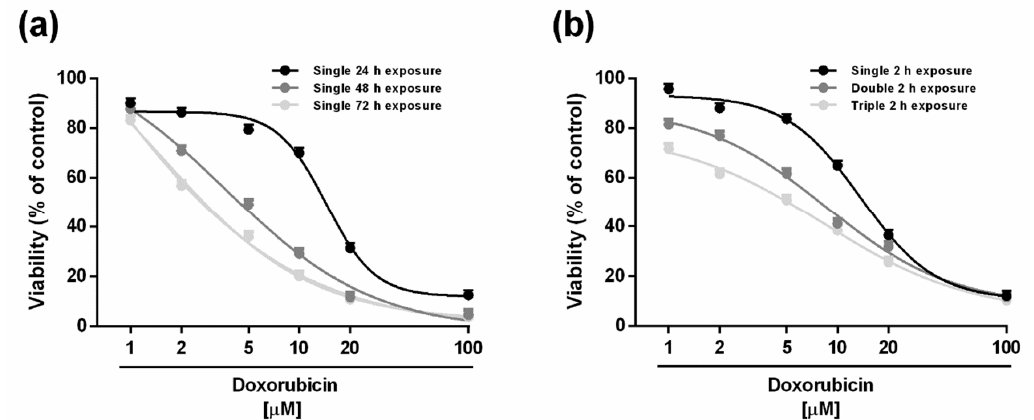
Figure 1. Cytotoxicity of the anticancer drug doxorubicin in HepG2 cells under single long-term exposures of 24, 48 and 72 h ( a ) and under the metronomic schedule. ( b ). In the last protocol, the cells were subjected to a short and / or repeated exposure of 2 h followed by a recovery time of 72 h. Data represent the mean ± SE (standard error) of at least two experiments in which each treatment was tested in triplicate ( n = 6).